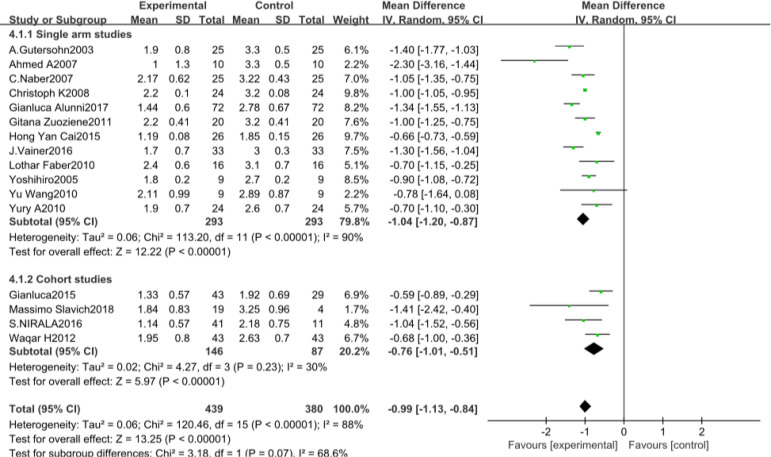
Forest map for the Canadian Cardiology Society class of the cardiac shock wave therapy group and the control group. CI=confidence interval; IV=inverse variance methods; SD=standard deviation